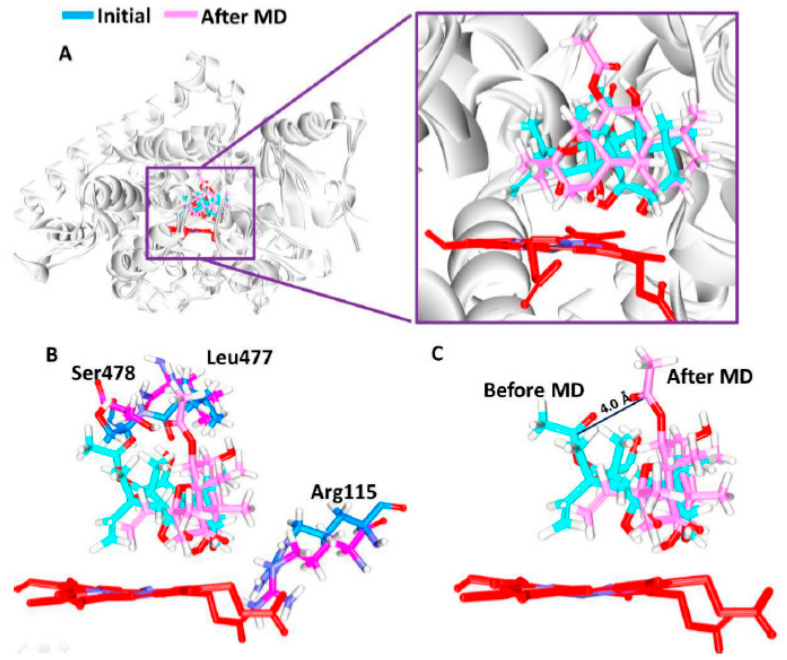
Figure 2. Accommodation of the ligand at the active site of the protein. ( A ) The ligand position before and after the molecular dynamics (MD) simulations. The ligand occupies in the substrate binding site. ( B ) The close residues appear to be unchanged. ( C ) The ligand moved 4 Å during the simulation. J. Clin. Med. 2018 , 7 , x FOR PEER REVIEW Table 2. Comprehensive intermolecular interactions.